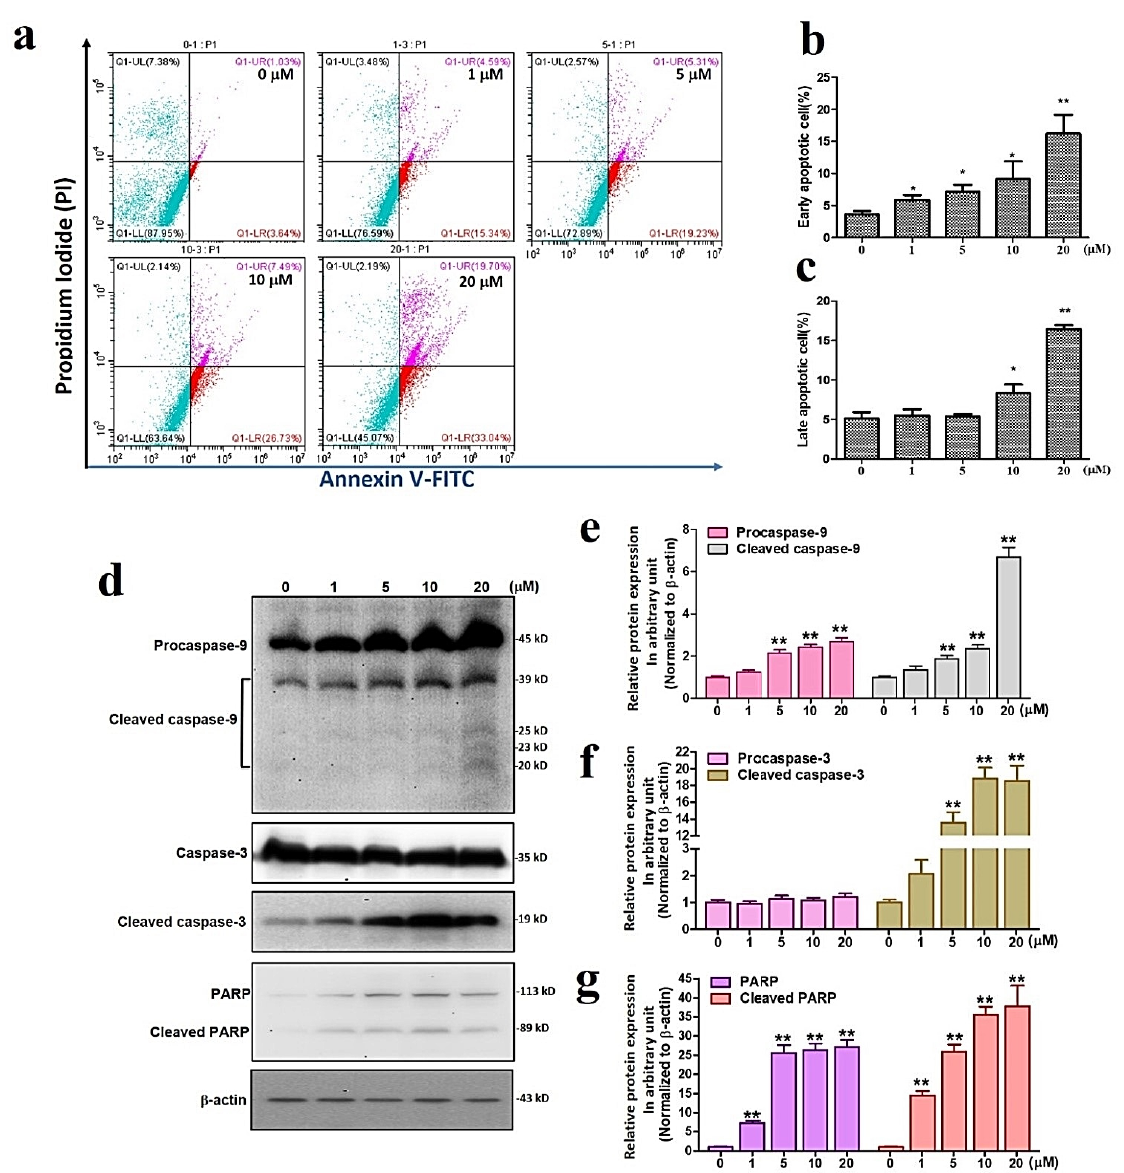
Figure 2. The effects of sinularin on apoptosis and DNA damage. ( a ) Annexin V/propidium iodine staining chart showing the effects of sinularin at 0–20 µ M on the death of U87 MG cells. ( b )